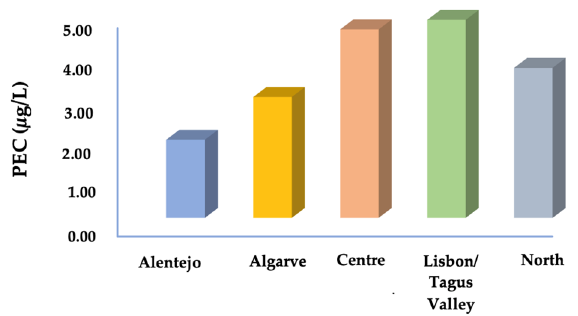
Figure 3. Predicted environmental concentration (exposure) of surface water in different regions. PEC values were obtained from the sum of each PEC-active substance.